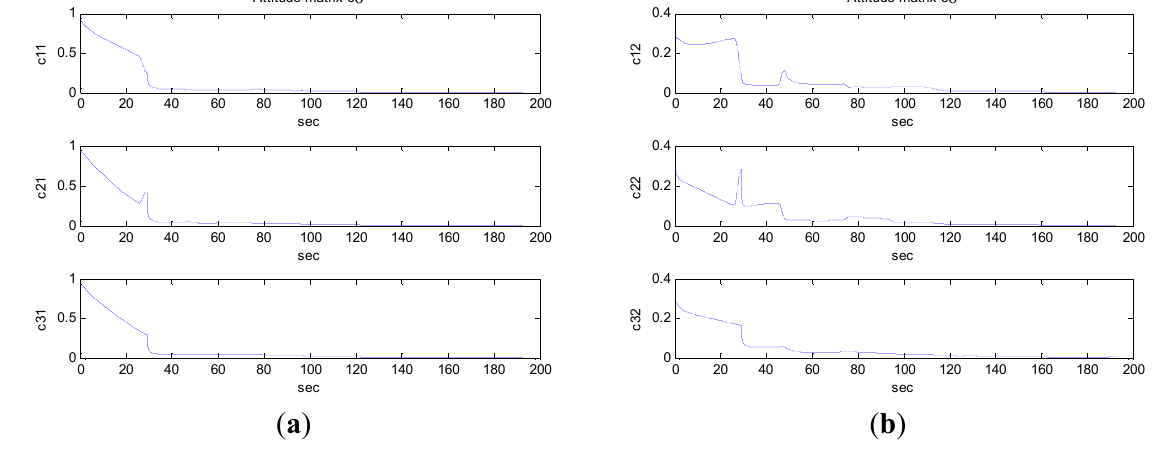
Figure 3. The 3 σ bounds for the errors in the attitude matrix and the velocities in the n